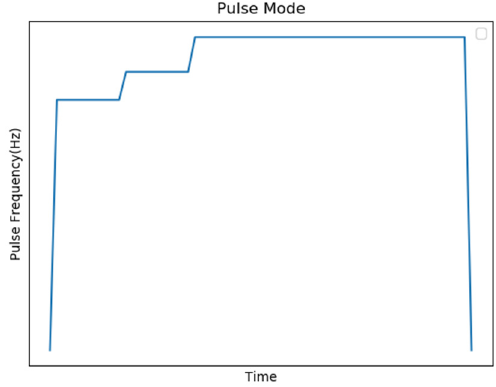
Figure 10. Schematic diagram of stepping motor control mechanism.